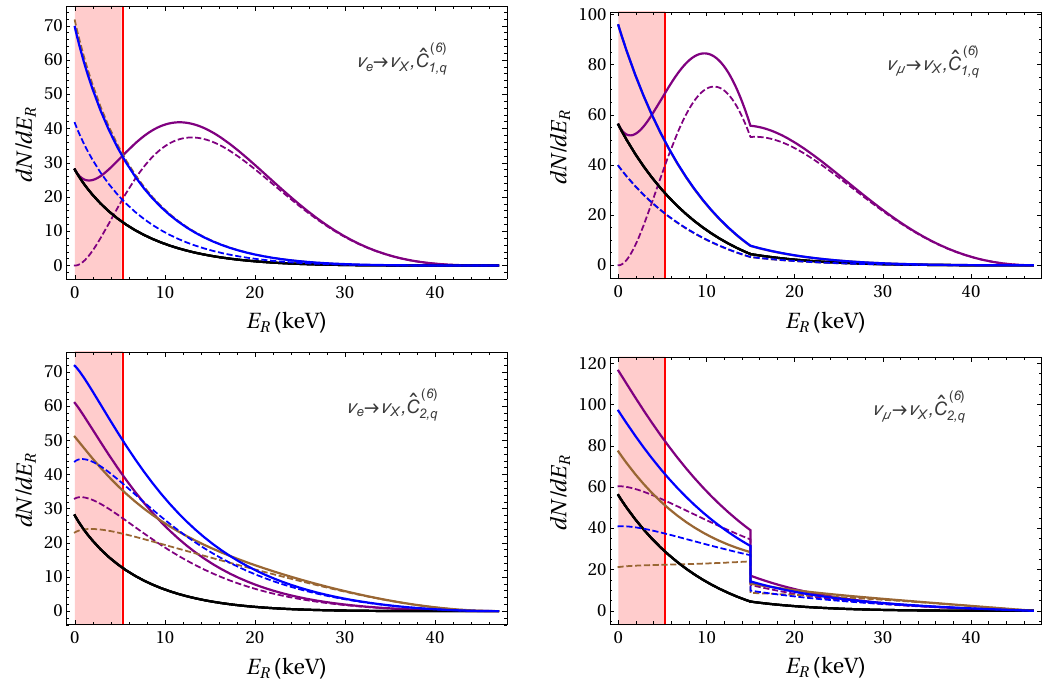
Figure 10 . The ν (left) and ν (right) scattering rates in the presence of a single e → ν e µ → ν µ (6) (6) (top) or (bottom), setting ˆ C (6) a = 1 / Λ 2 , where Λ is taken NSI operator, either a ;min 1 ,q 2 ,q a ;min Q Q to be the corresponding lower bound in tables 2 and 3, respectively. The SM event rate is denoted by the black solid line, dashed lines denote NSI only and solid lines the sum of SM and NSI contributions (with blue, brown and purple representing couplings to up, down and strange quark currents, respectively). The energy threshold of the experiment is denoted by the vertical red